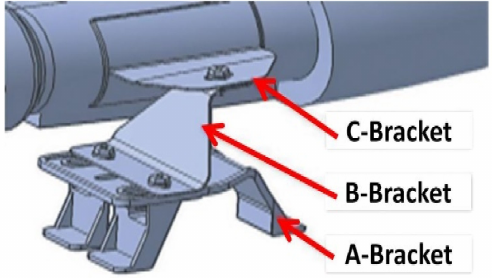
Figure 15. Types of A-, B-, and C-bracket